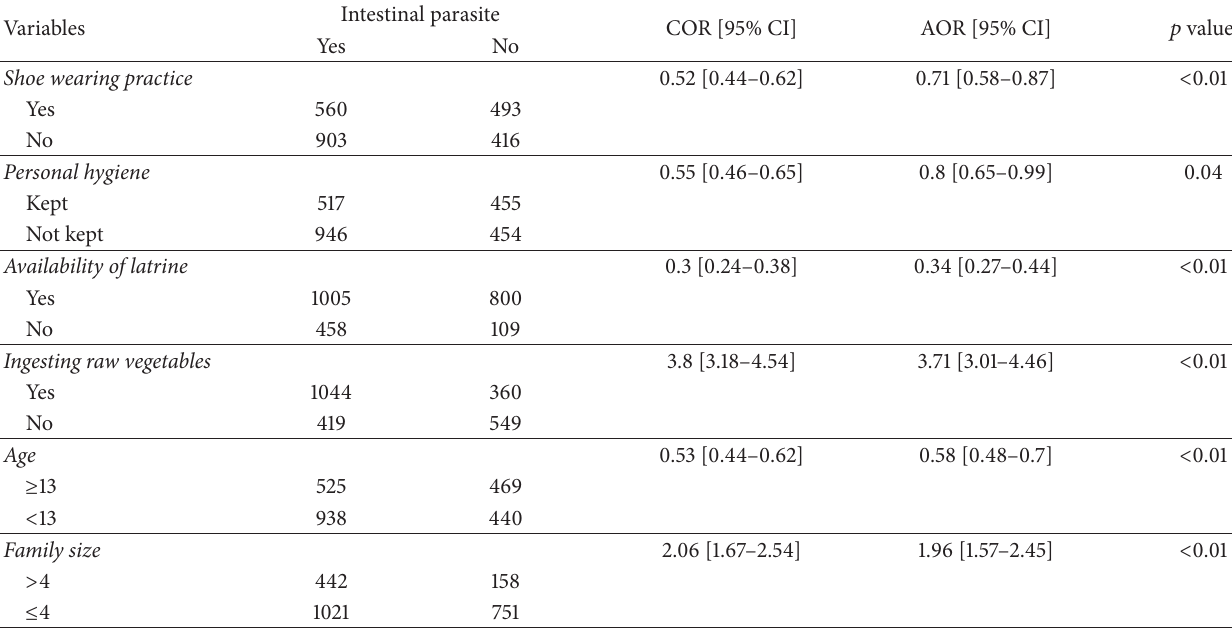
Table 3: The determinants of intestinal parasite in school age